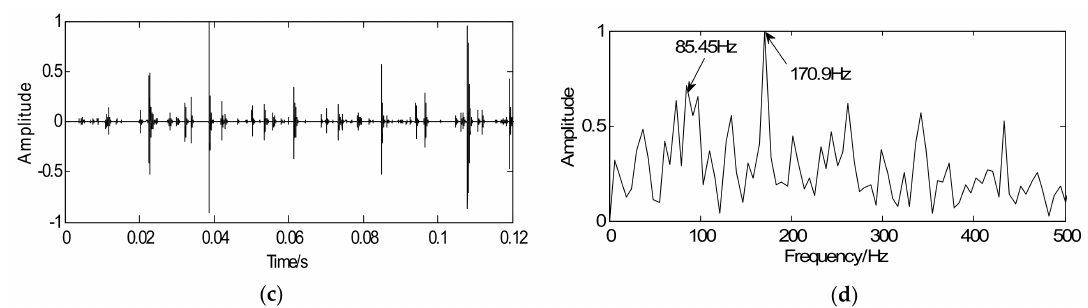
Figure 13. Detection results of outer-race fault signals using the traditional method: ( a ) Optimal wavelet basis, ( b ) sparse coefficients, ( c ) reconstructed signal, and ( d ) envelope spectrum of the reconstructed signal.